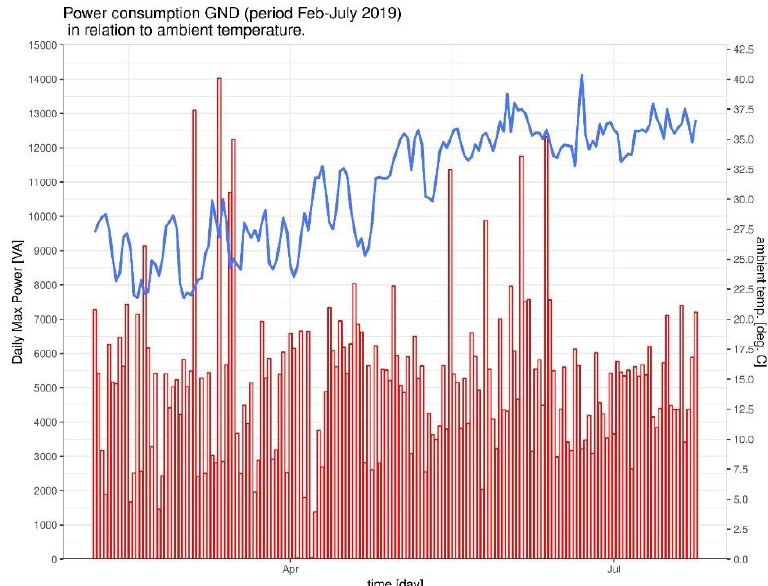
Figure 13. The daily maximum power demand, in the ground floor, in relation to daily mean ambient temperature (blue line) in the measurement period from February to July 2019.